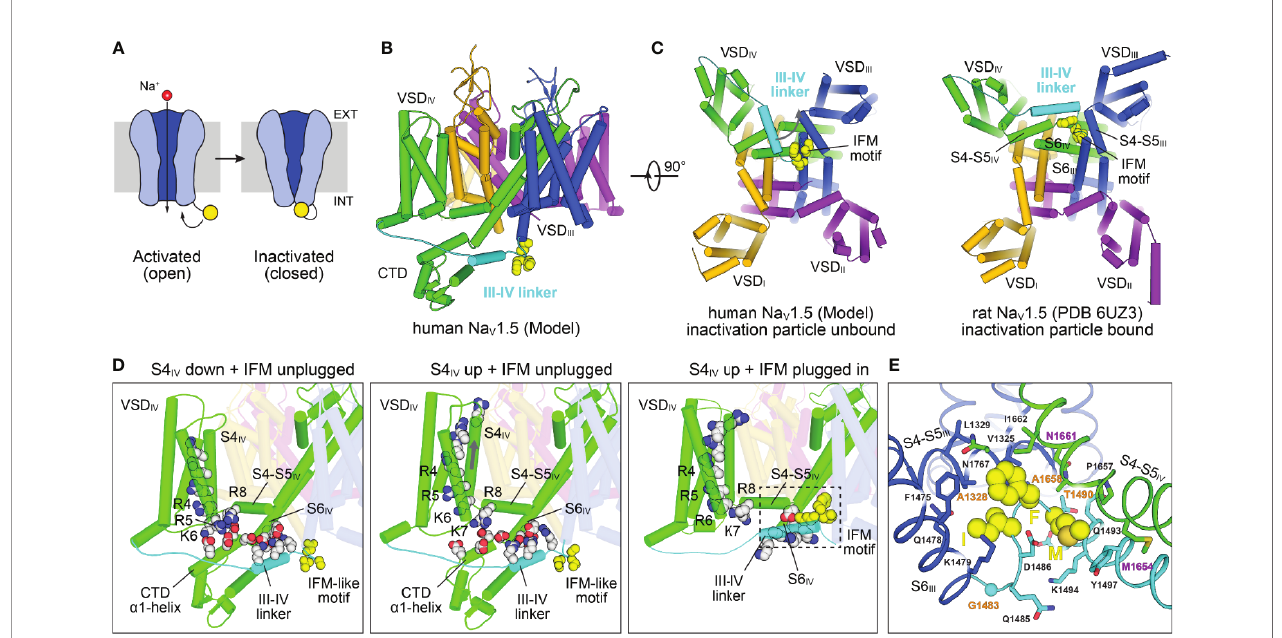
FIGURE 6 | Structural mechanisms of Na V channel inactivation. (A) Na V channels transition from an activated open state to a non-conducting inactivated state after depolarization. Inactivation is induced by binding of a C-terminal motif (yellow) to the cytosolic side of the channel leading to pore closure. The cell membrane is indicated with a gray rectangle, with the extracellular (EXT) and intracellular space (INT) labeled. (B) Closed state model of SCN5A (Kroncke et al., 2019) highlighting structural elements involved in fast inactivation. The III-IV linker (cyan) connecting S6 III (blue) with VSD IV (green) contains the IFM motif (yellow spheres) which is